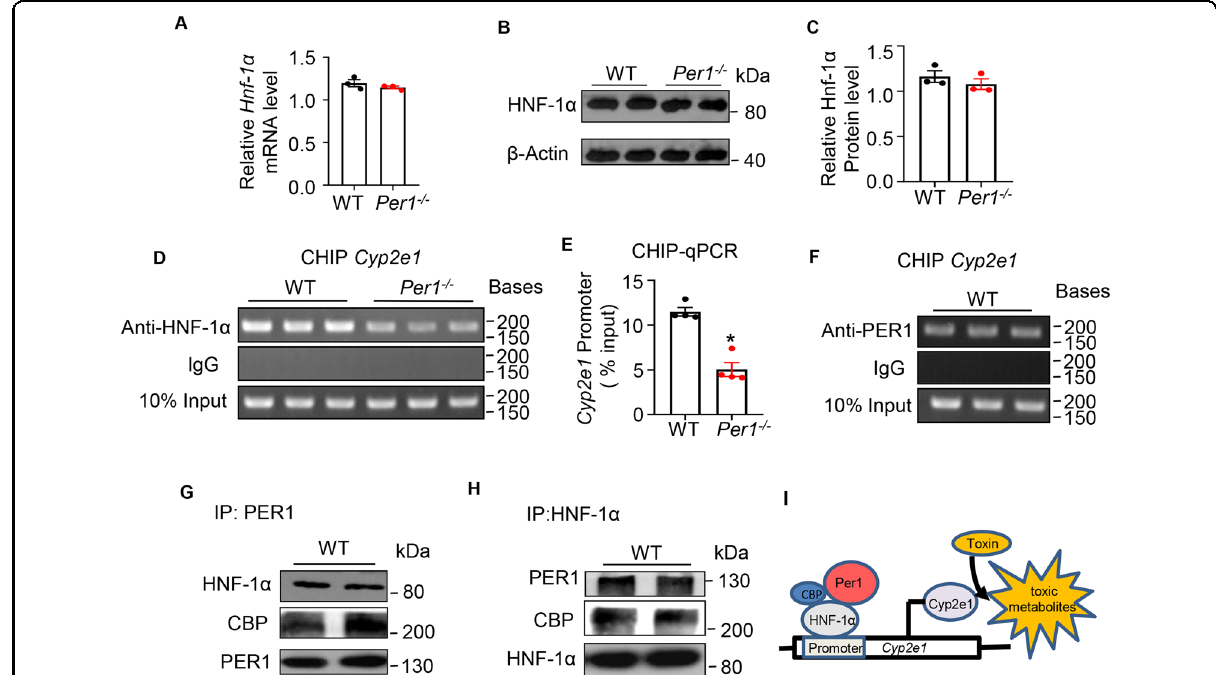
Fig. 7 PER1 interacted with HNF-1 α on Cyp2e1 promoter. A Hepatic mRNA levels of HNF-1 α were measured in Per1 − / − and WT mice. B – C Hepatic protein levels of HNF-1 α were analyzed by western blot and β -actin was used as internal control. D Recruitments of HNF-1 α to Cyp2e1 promoter were detected by ChIP assays. E ChIP assays were performed followed by real-time PCR. F Recruitments of PER1 to Cyp2e1 promoters were detected by ChIP assays. G – H Representative immunoblots showing recovery of the indicated proteins from mouse liver after immunoprecipitation with the indicated antibodies. I A hypothetical model of how PER1 interacted with HNF-1 α on Cyp2e1 promoter and target gene transcription. Data were shown as means ± S.E.M. N = 5 independent biological replicates per group; * P < 0.05, Per1 − / − group versus WT